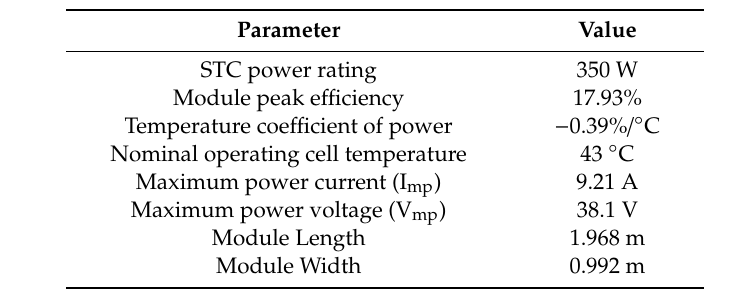
Table 2. PVmodule characteristics